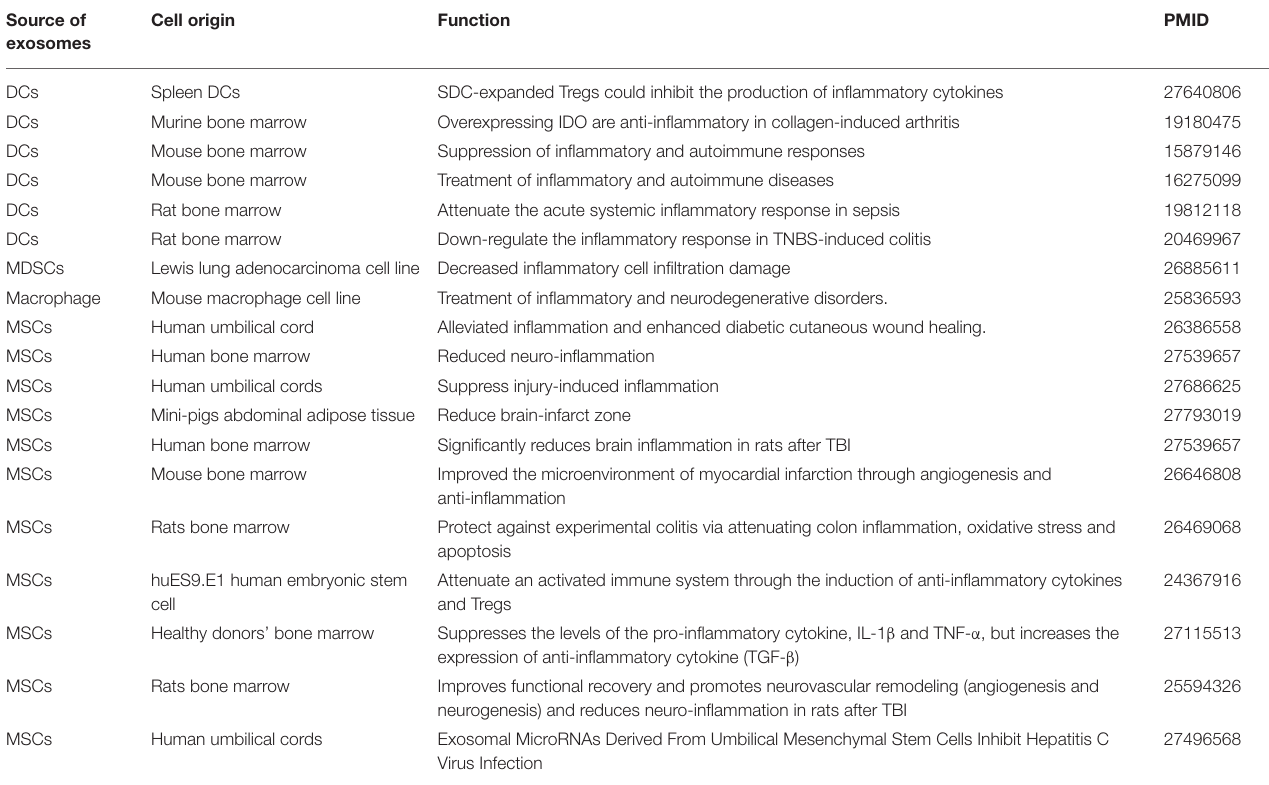
TABLE 3 | A long list of publications have reported that various immune cell-, and immunosuppressor cell-derived exosomes have anti-inflammatory effects. Source of